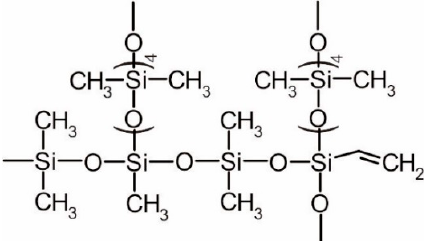
Figure 3. Simplified structure of partially crosslinked silicone resin obtained in synthesis of SIL 1 and SIL 2 dispersions.